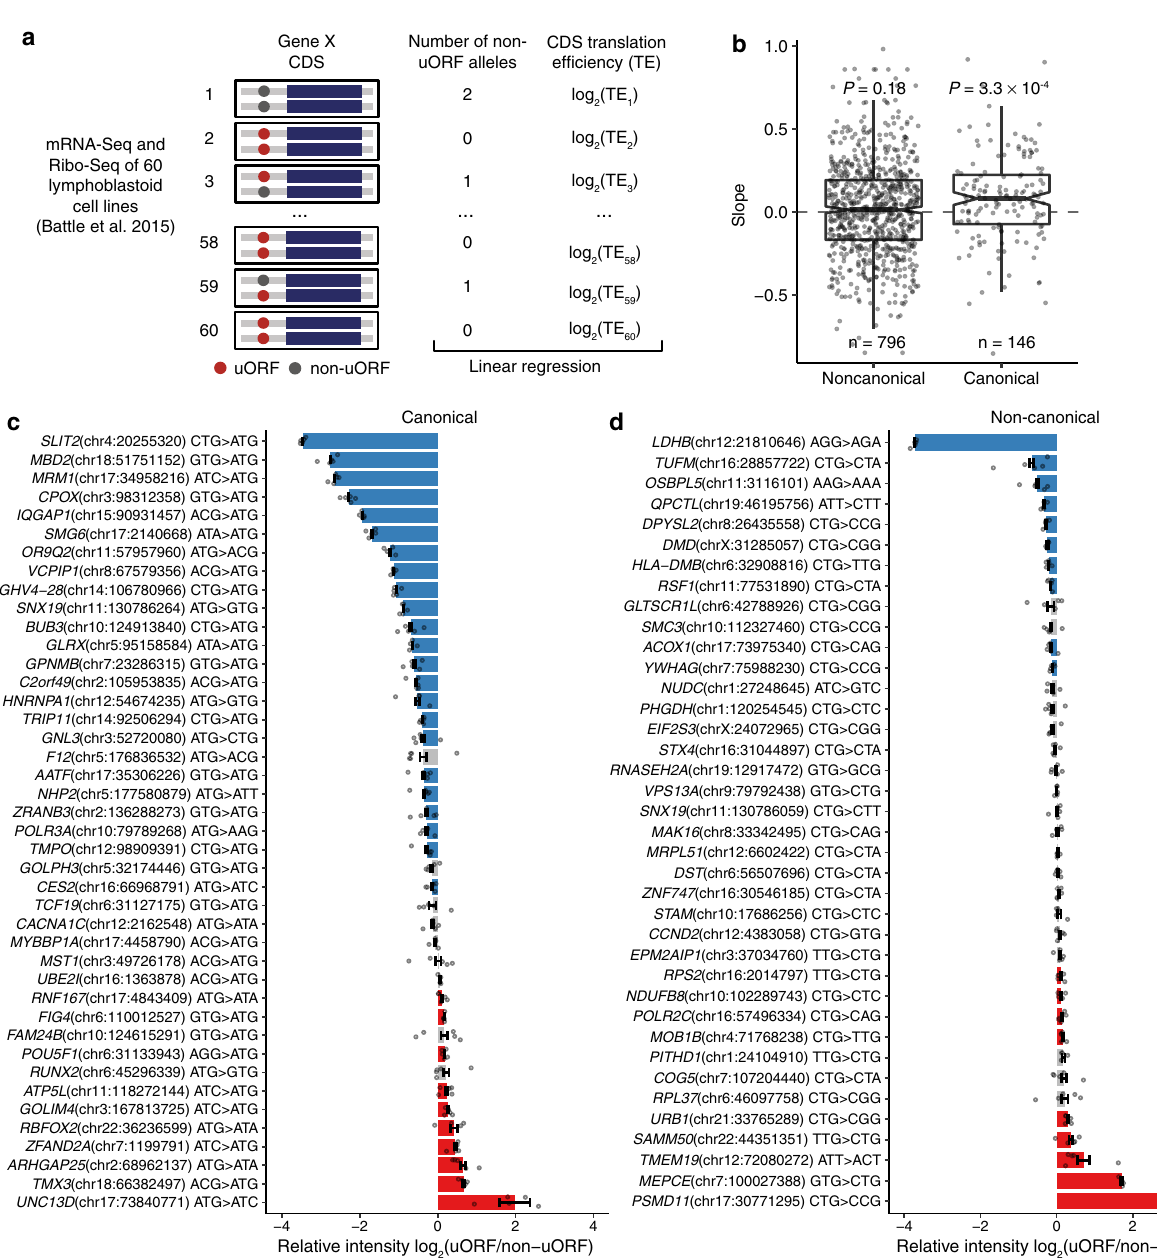
MST1 (chr3:49726178) ACG>ATG UBE2I (chr16:1363878) ACG>ATG RNF167 (chr17:4843409) ATG>ATA FIG4 (chr6:110012527) GTG>ATG